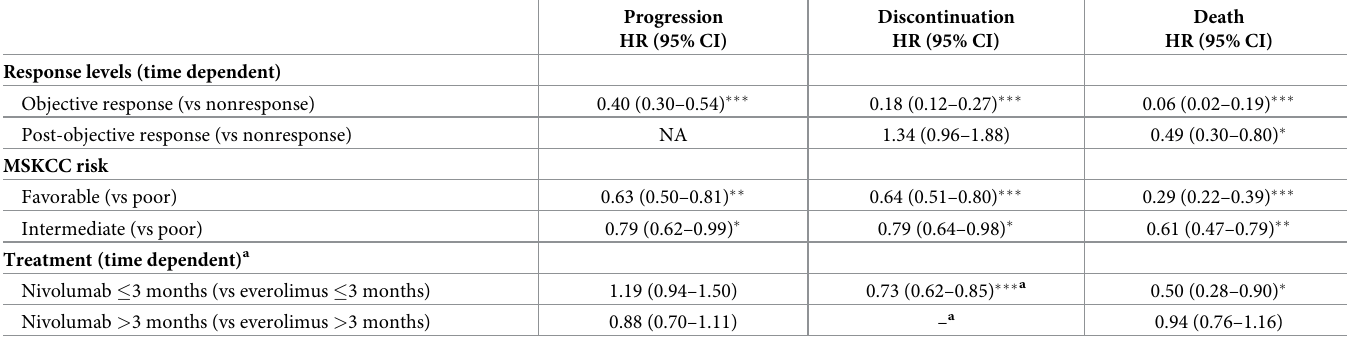
TTD, TTP, and TTDeath for the reference arm (everolimus, no response, poor MSKCC risk) were modeled using Weibull distributions; times to response and to loss of response were modeled using log-normal and Gompertz distributions, respectively (S2 Table). Achievement of response, MSKCC risk group, and treatment were influential predictors for progression, treatment discontinuation, and death (Table 2). It is important to note that there is a correlation between treatment and its duration with response levels achieved. Objective response achievement significantly reduced risk of Table 2. Multivariate Cox regression analysis–dynamic